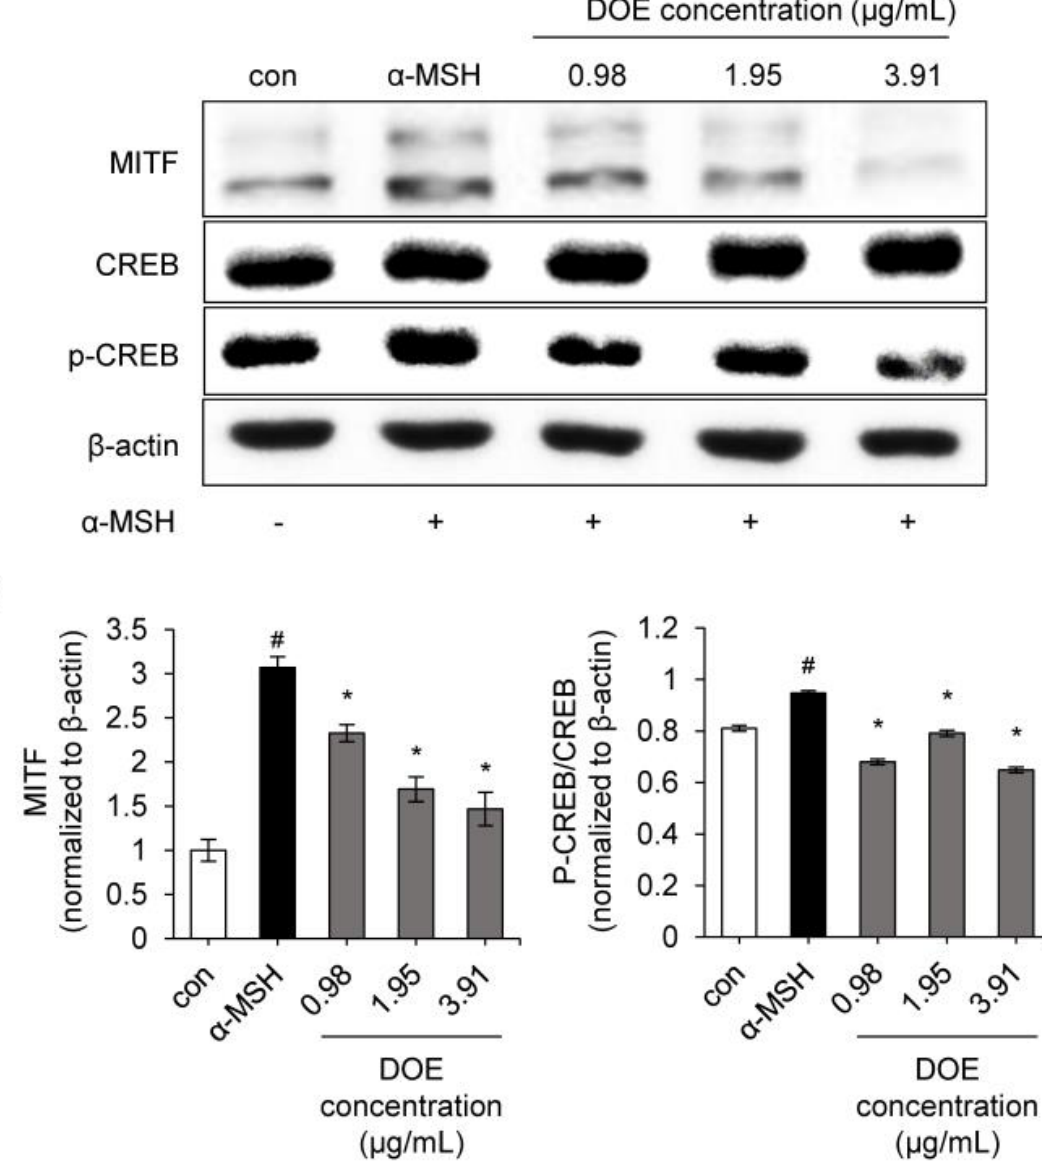
Figure 5. ( a ) Effects of the DOE on the protein expressions of MITF, p-CREB, and CREB in B16F10 cells. B16F10 cells were treated with different concentrations of DOE ranging from 0.98 to 3.91 µ g/mL. Protein expressions of MITF, p-CREB, and CREB were analyzed by Western blotting. Equal protein loading was confirmed using β -actin antibody. ( b ) Protein levels of MITF, p-CREB, and CREB proteins. The relative level of each protein was calculated based on the intensity of actin protein and CREB. # p < 0.05 vs. control. * p < 0.05 vs. α -MSH-treated group.